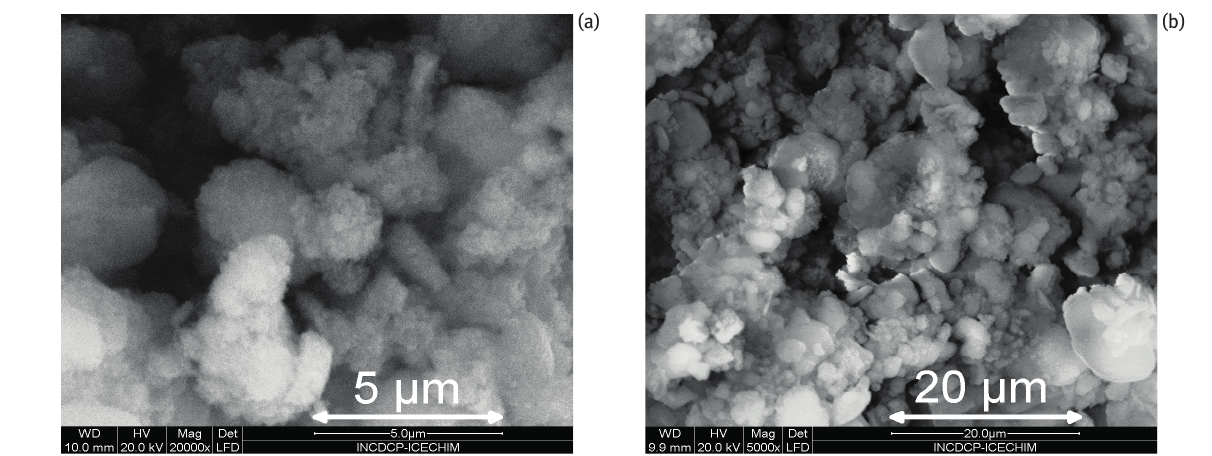
Figure 3: SEM image of NPK 111 fertilizer (d